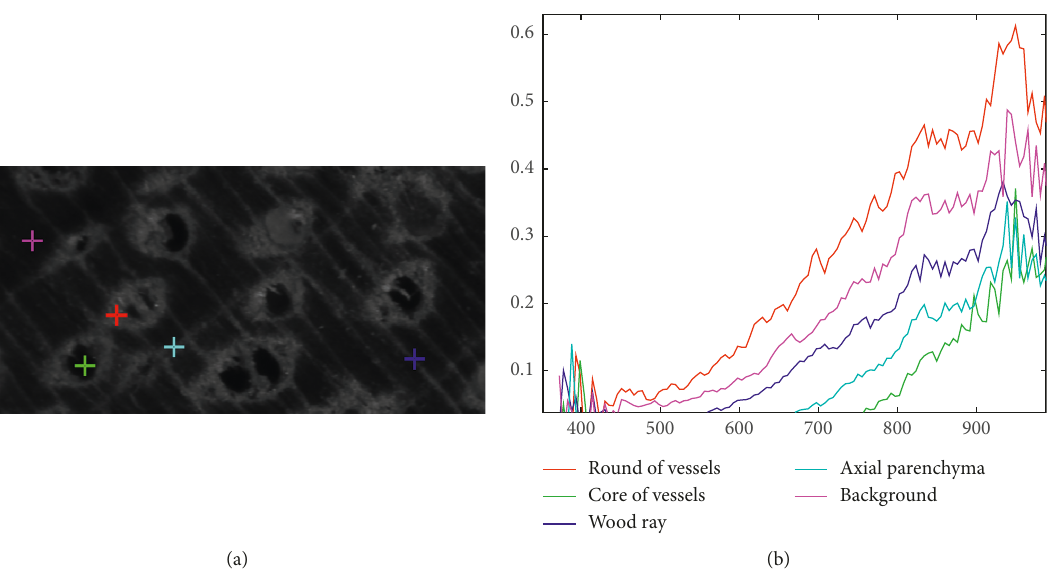
Figure 2: Spectral curves for different tissues of Intsia bijuga : (a) the 5 cross marks indicate different tissues; (b) corresponding spectral curves for each tissue.